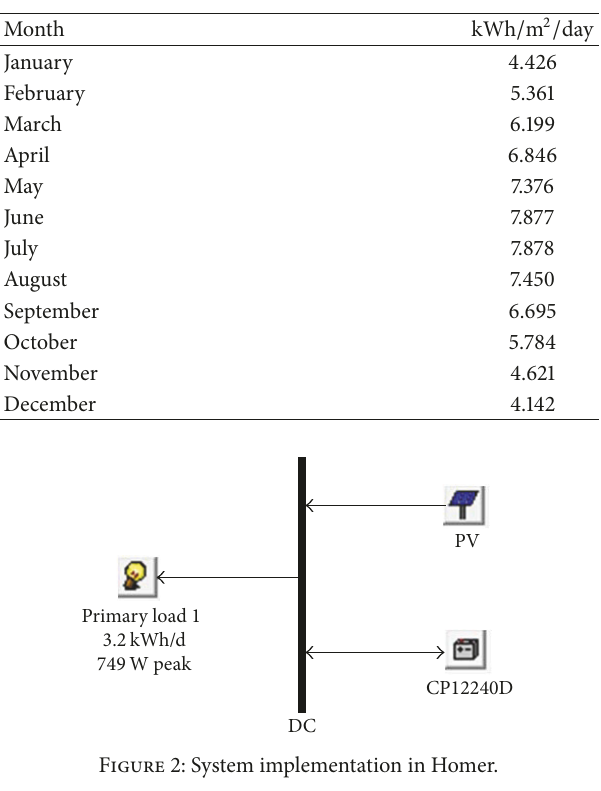
Table 2 indicates monthly averaged insolation incident on 2 / day ) in Libya [10]. a horizontal surface ( kWh / m